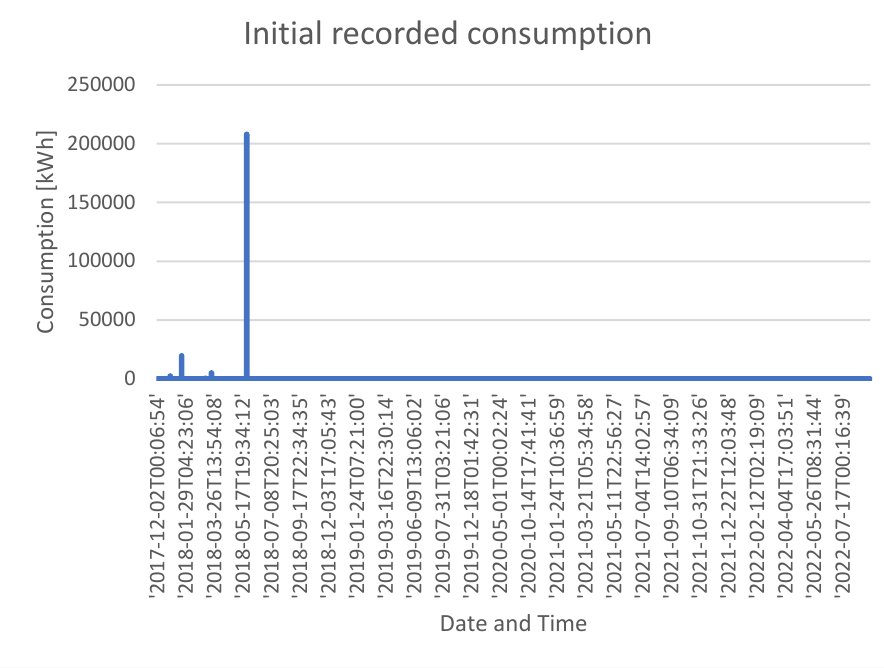
Figure 3. Initial consumption recorded by the BEMS TUCN application at the swimming complex.